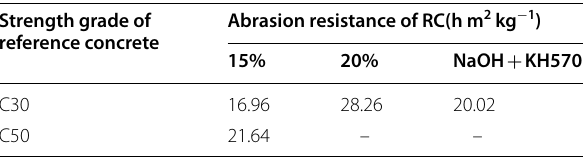
Table 5 Abrasion resistance of typical